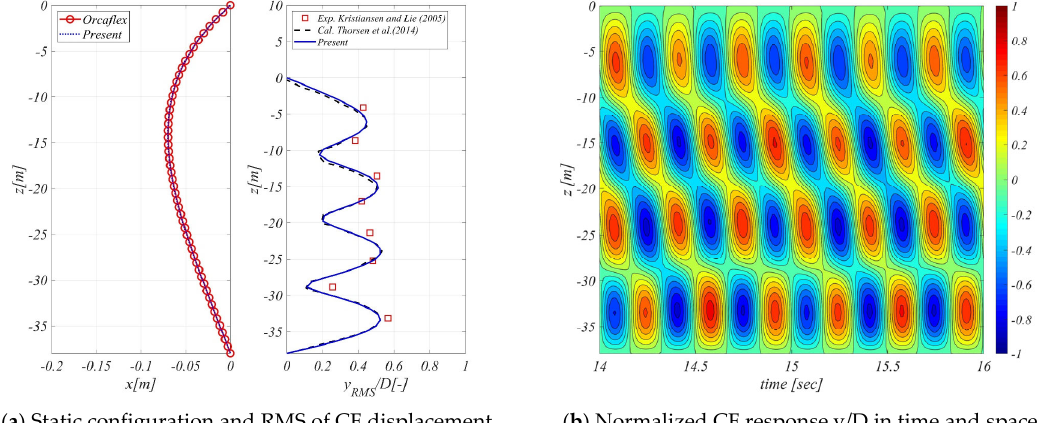
Figure 18. Static configuration and cross flow displacement with shear current ( 𝑈 (cid:3040)(cid:3028)(cid:3051) = 0.6m/s).